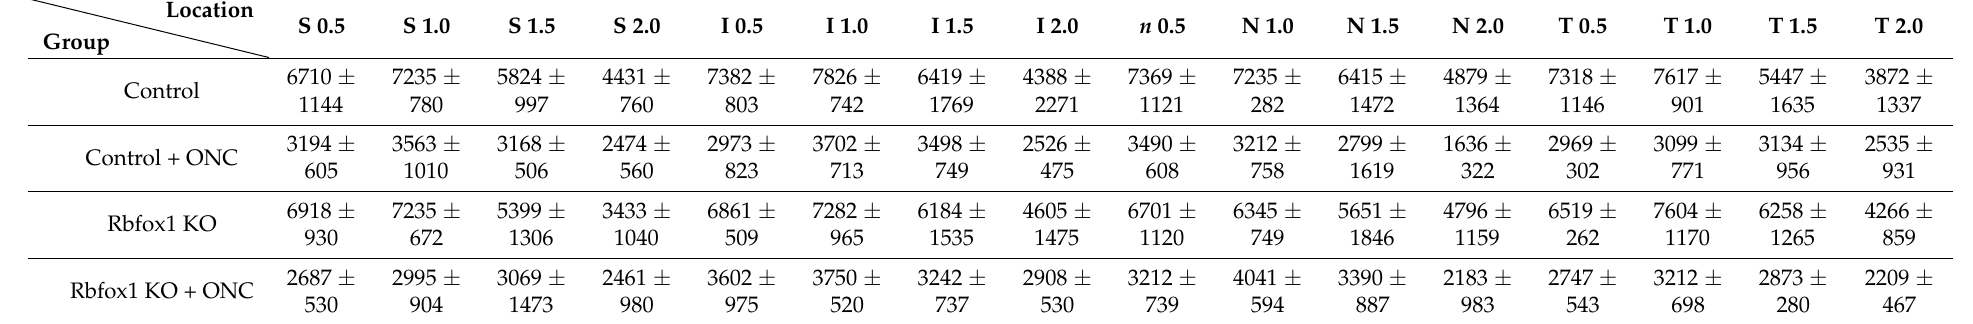
Table 1. Densities of Rbpms-positive cells in retinas of control and Rbfox1 KO animals with and without ONC injury (per mm 2 ).